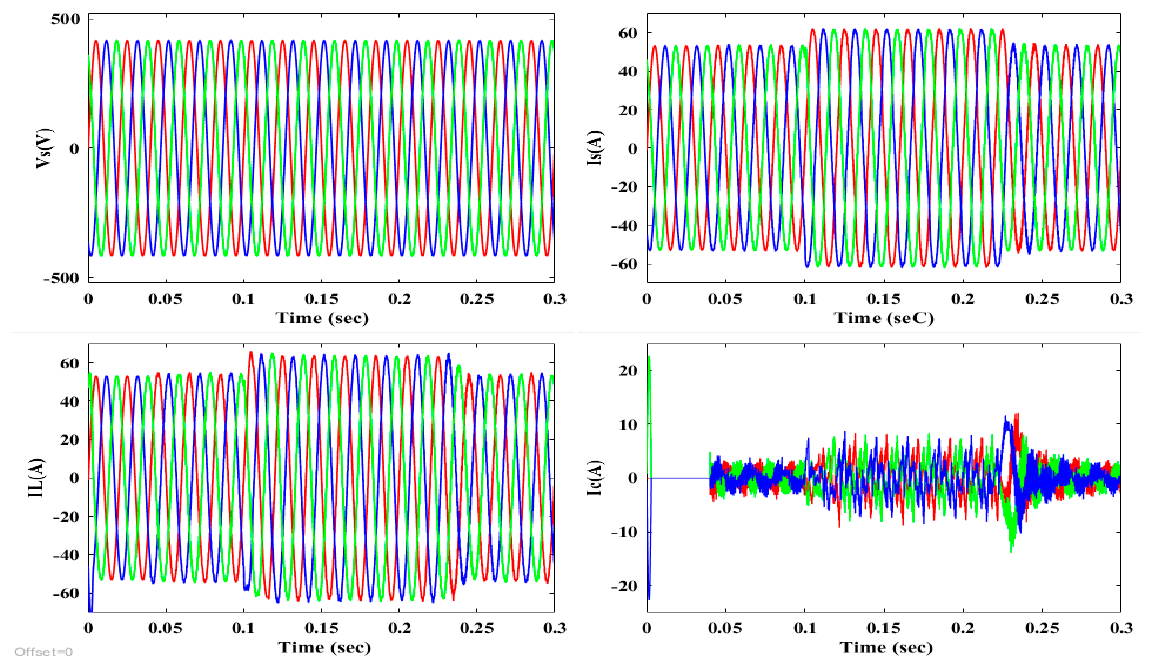
Figure 12. PCC voltage V(s), Grid current (Is), Load current (I L ), Inverter Terminal out current I(c).